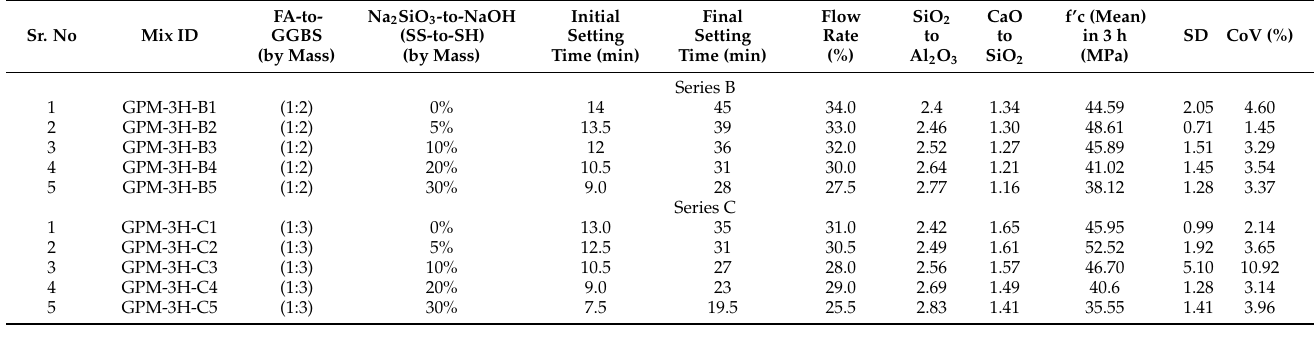
Figure 13. Compressive strength test results for the geopolymer specimen using various Na2SiO3- to-NaOH and FA-to-GGBS ratios with sand preheated at 110 °C and cured in a hot oven at a uniform temperature of 50 °C for 3 h.